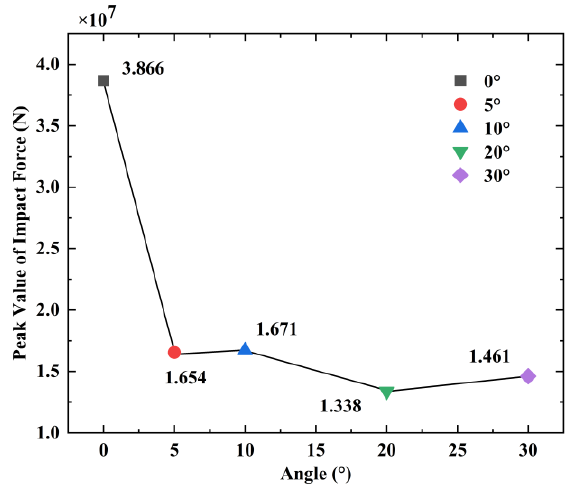
Figure 16. Variation of peak values of impact force with respect to impact angles.